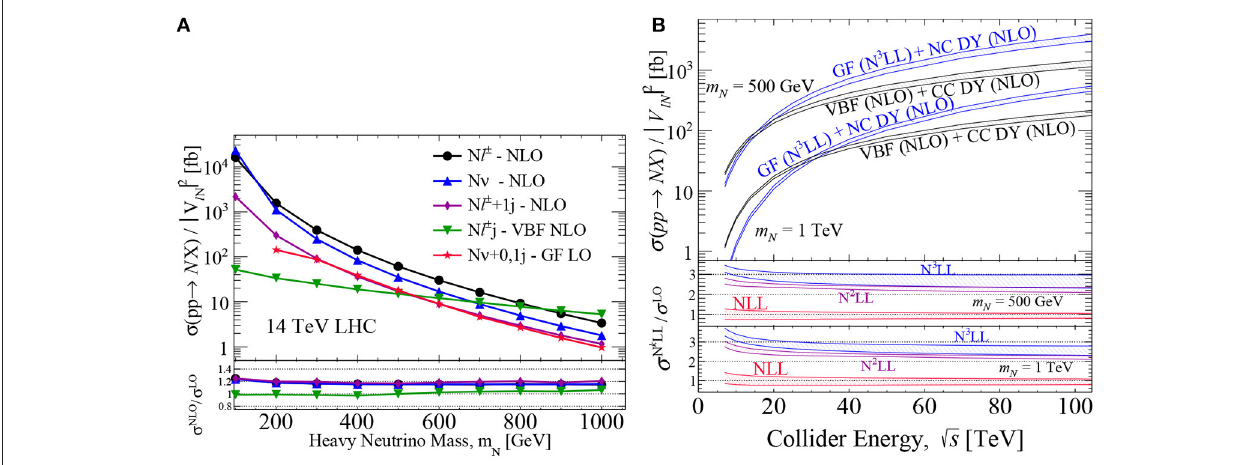
2 , for various production modes as a function of (A) N V ℓ N | |